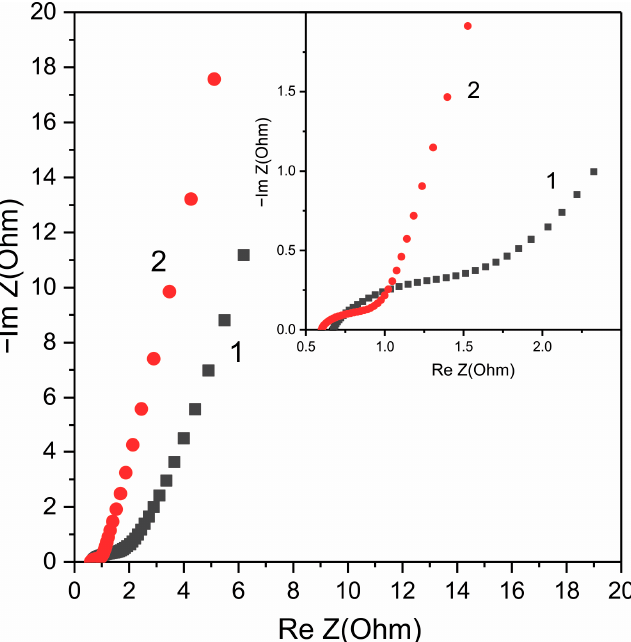
Figure 6. Nyquist plots of Co 3 O 4 NPs–NF electrode with loading 3 mg before (1) and after (2) H2- treatment in the frequency range of 0.01–5 × 10 4